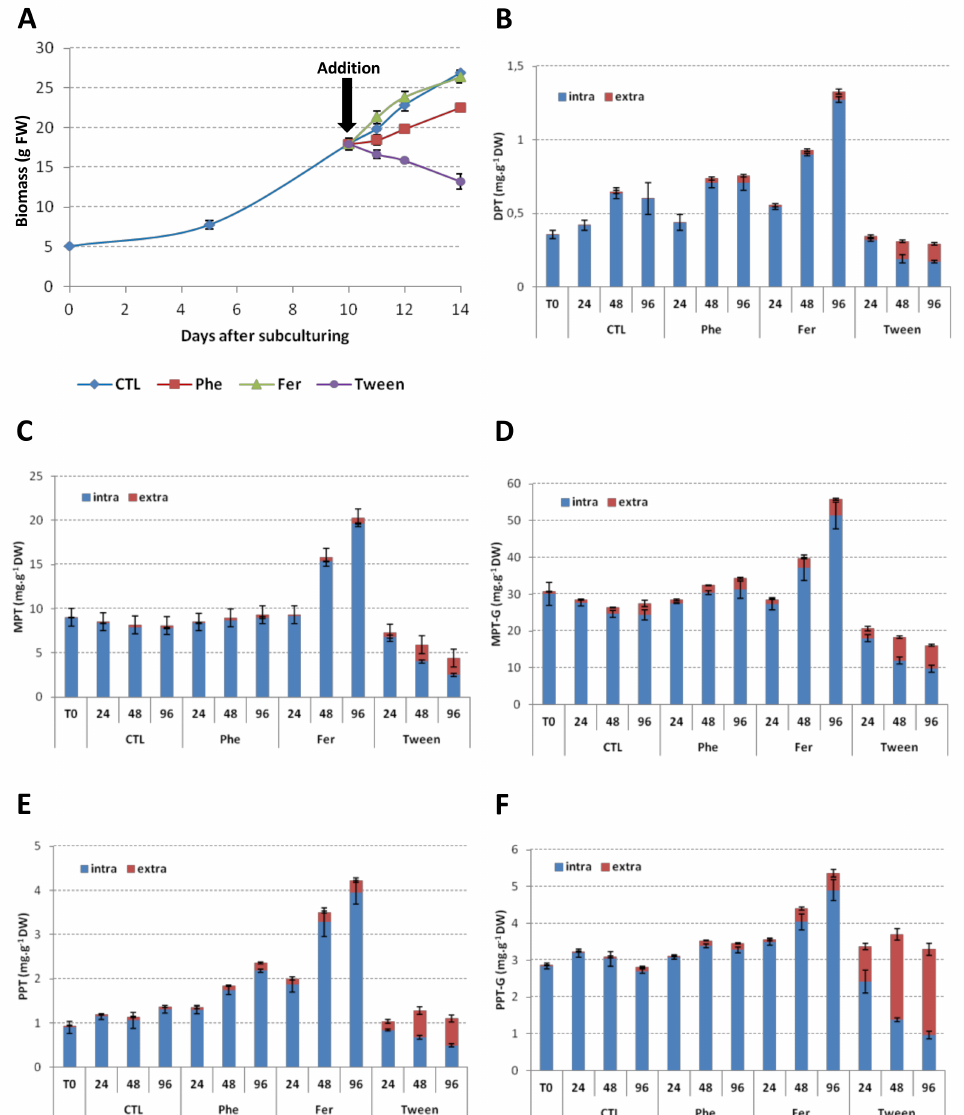
Figure 6. Impact of precursors feeding and permeation on the growth and ATL accumulation profiles of HRLF15.2 line. ( A ) Growth curves of HRLF15.2 line fed with L -Phe (1 mM) or ferulic acid (1 mM) or treated with Tween-20 (2% w / v ); ( B ) Impact of L -Phe (1 mM) or ferulic acid (1 mM) or Tween-20 (2% w / v ) addition on the intracellular and extracellular accumulation kinetic of DPT in HRLF15.2 line; ( C ) Impact of L -Phe (1 mM) or ferulic acid (1 mM) or Tween-20 (2% w / v ) addition on the intracellular and extracellular accumulation kinetic of MPT in HRLF15.2 line; ( D ) Impact of L -Phe (1 mM) or ferulic acid (1 mM) or Tween-20 (2% w / v ) addition on the intracellular and extracellular accumulation kinetic of MPTG in HRLF15.2 line; ( E ) Impact of L -Phe (1 mM) or ferulic acid (1 mM) or Tween-20 (2% w / v ) addition on the intracellular and extracellular accumulation kinetic of PPT in HRLF15.2 line; ( F ) Impact of L -Phe (1 mM) or ferulic acid (1 mM) or Tween-20 (2% w / v ) addition on the intracellular and extracellular accumulation kinetic of PPTG in HRLF15.2 line. Data on L -Phe or ferulic acid uptakes are presented Figure S4. Each point is the mean and standard deviation of the three independent